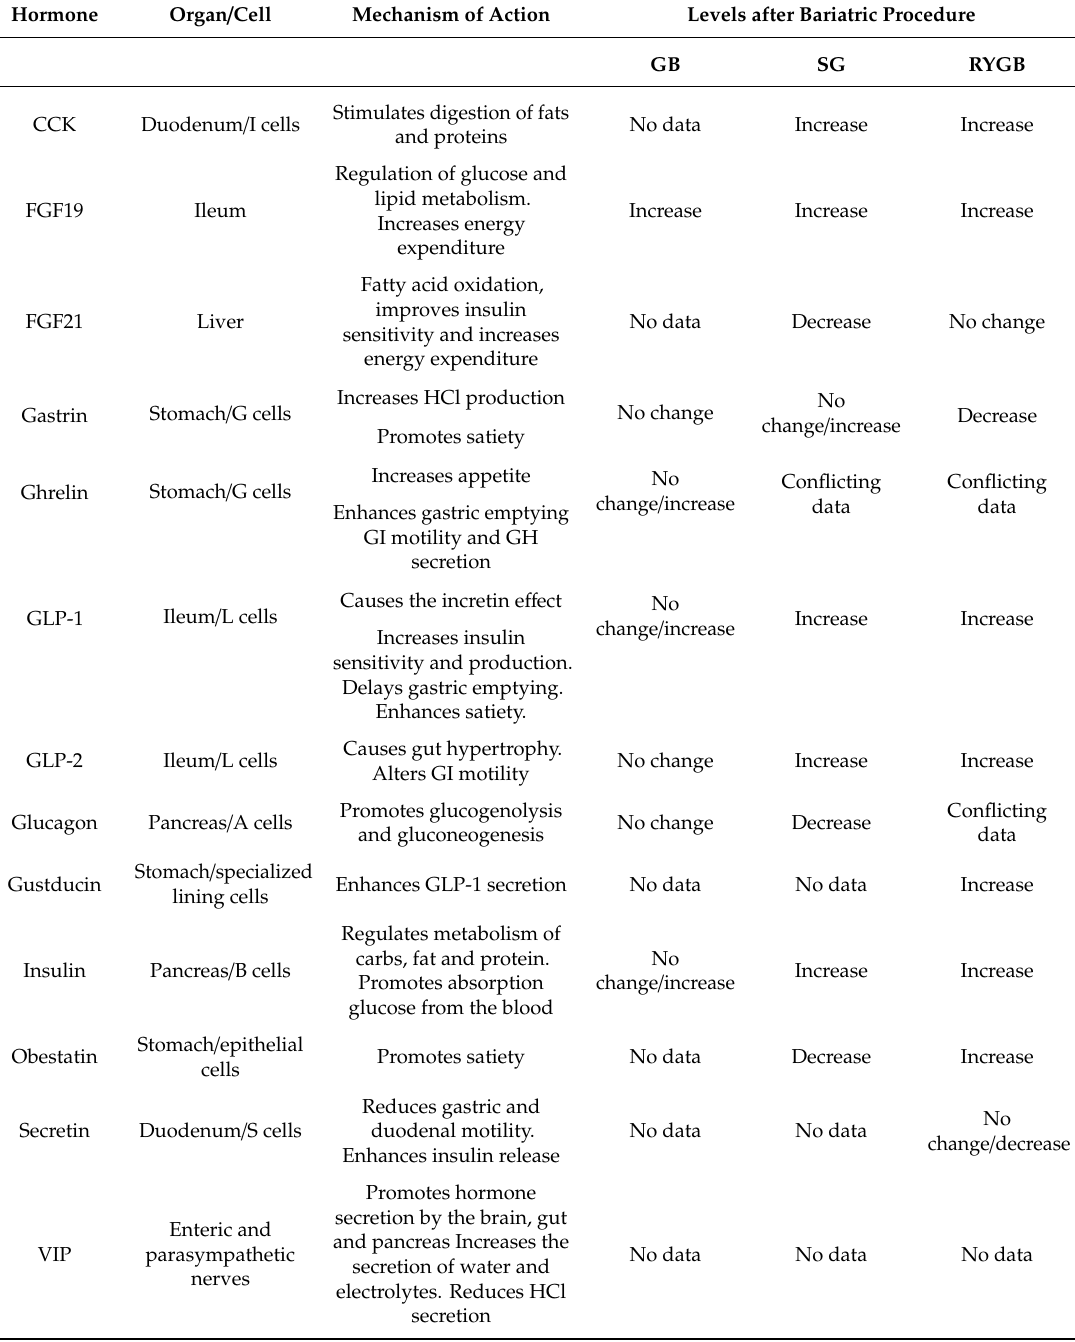
Table 8. Gut hormones and their actions and e ff ects; three common bariatric procedures on gut hormone regulation